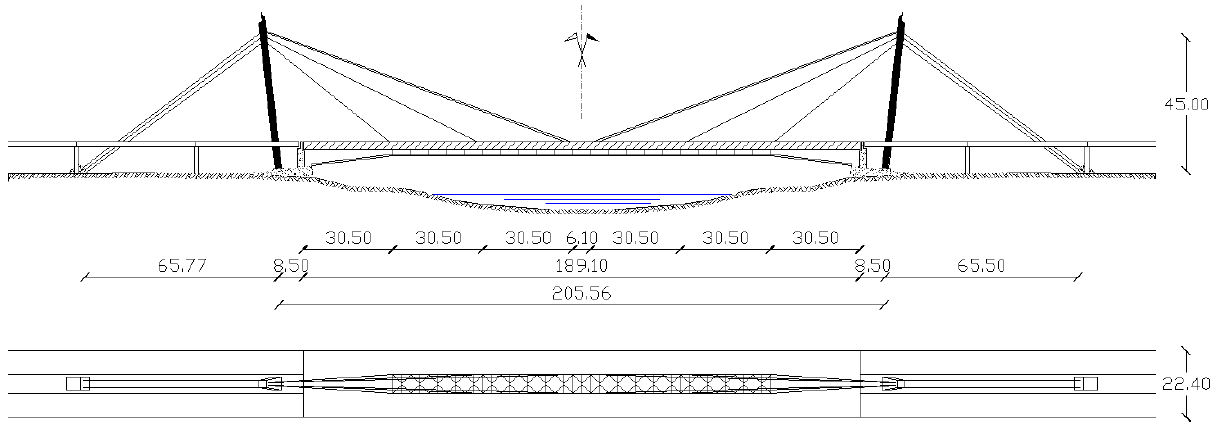
Figure 2. General dimensions of the bridge.